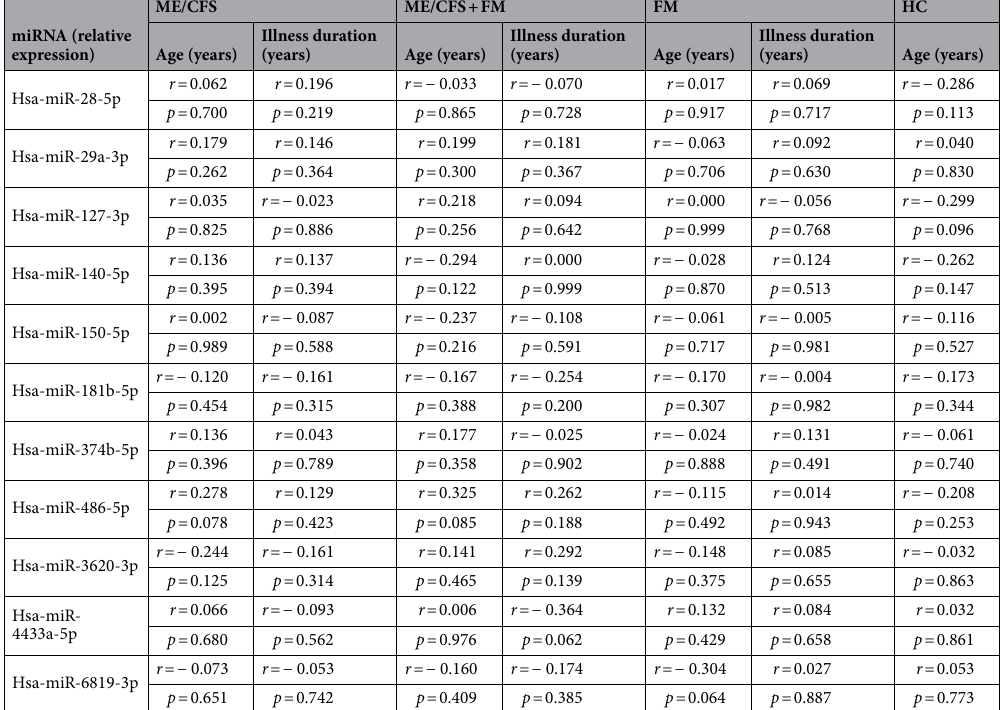
Table 3. Impact of age and illness duration on miRNA expression. Pearson’s correlation coefficient (r) and the P-values are presented. P values < 0.05 were considered